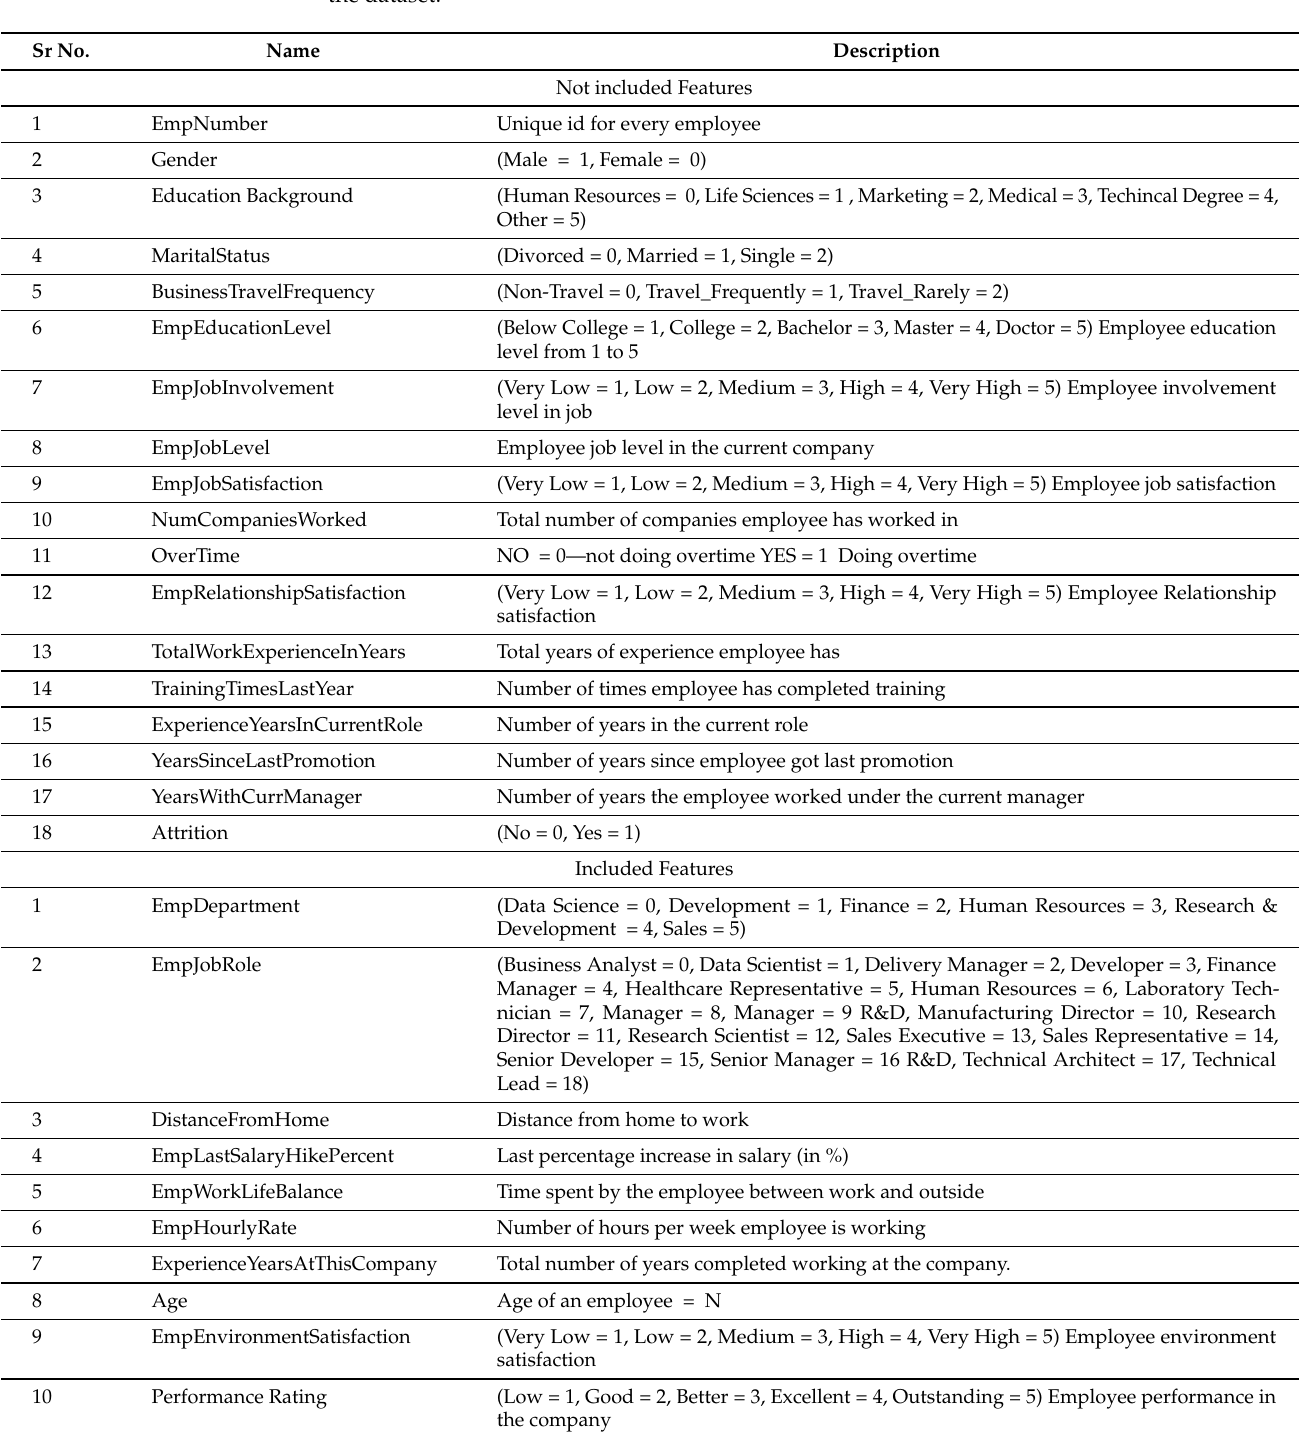
Table 2. Parameters considered for the classification of employee performance mentioned in the